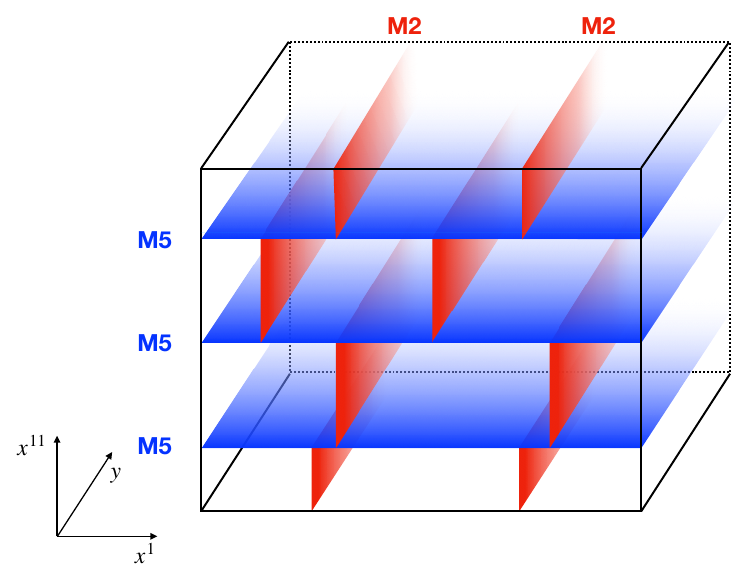
Figure 1 . Cross-section of N 1 = 2 M2 branes splitting into strips between N 5 = 3 M5 branes. The vertical axis is the M-theory direction, and the horizontal axis represents one of the internal directions of the M5 branes, x 1 . The strips can carry momentum along the y -circle, which is common to the M2 and M5 branes.